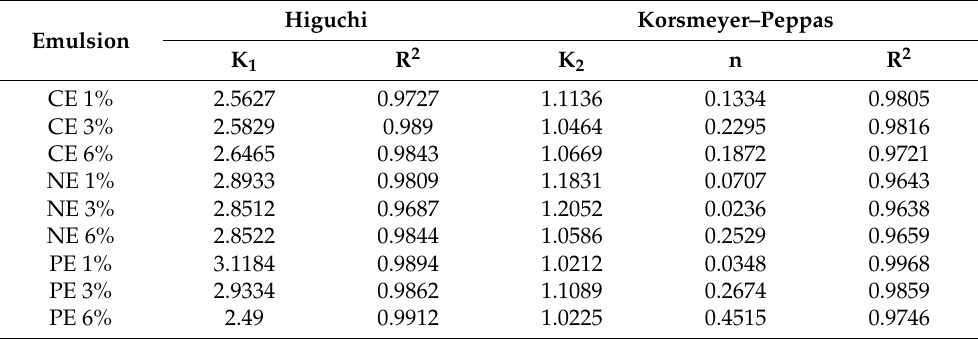
Table 4. Parameters of Higuchi/Korsmeyer–Peppas model for release properties of LDPE film treated with cold plasma containing CE-, NE-, and PE-stabilized